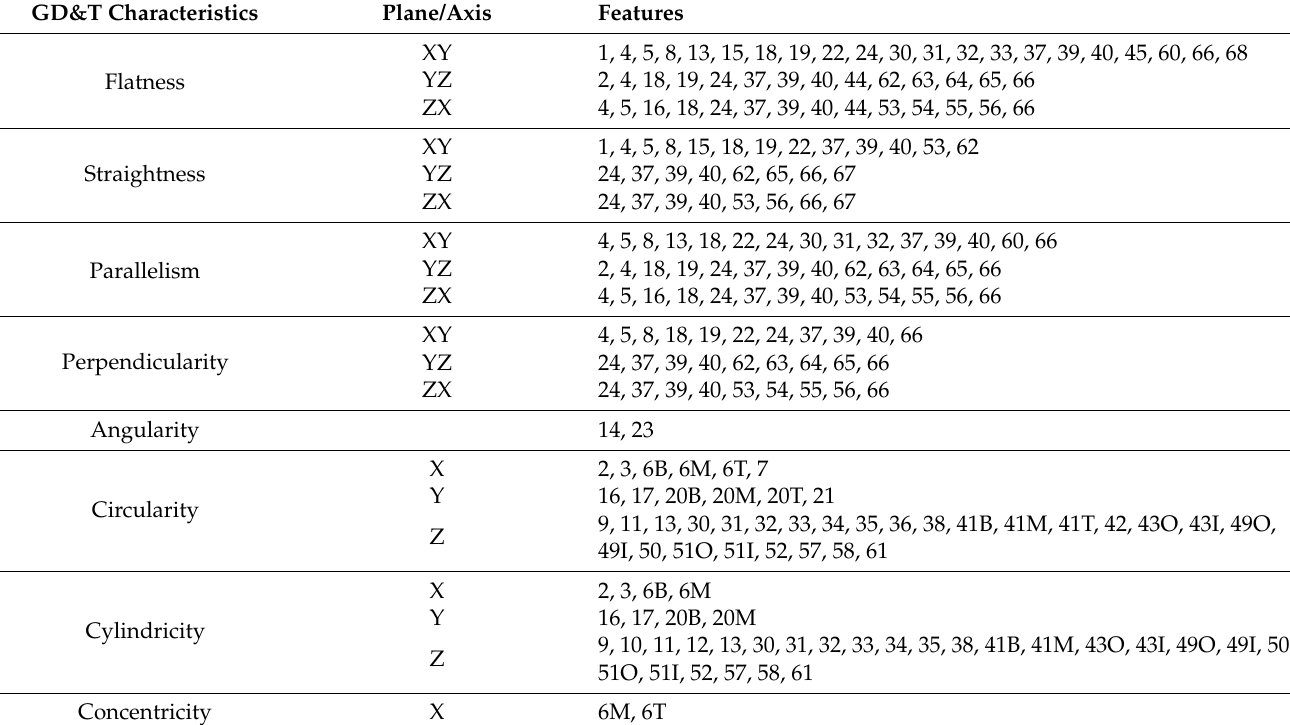
Table A2. GBTA features description as per the